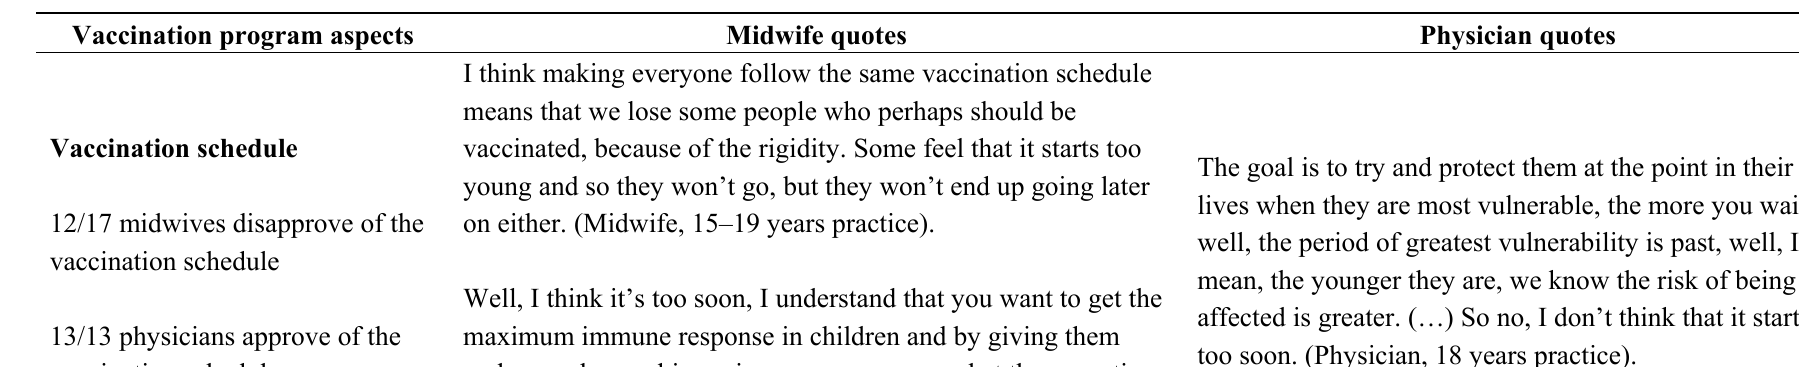
Table 2. Midwives’ and physicians’ opinions regarding some aspects of the Quebec national vaccination